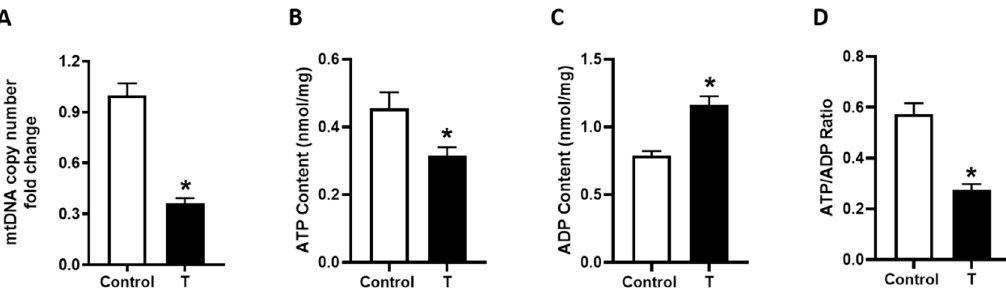
Figure 3. Mitochondrial copy number and ATP levels in the placenta of control and T-treated pregnant rats. ( A ) Mitochondrial DNA copy number was quantified using qRT-PCR based analysis. Placental ( B ) ATP and ( C ) ADP content was quantified using ApoSENSOR ADP/ATP kit. ( D ) Measurement of the ATP/ADP ratio. Data presented as mean ± SEM of 6 rats in each group. * p < 0.05 vs. control.